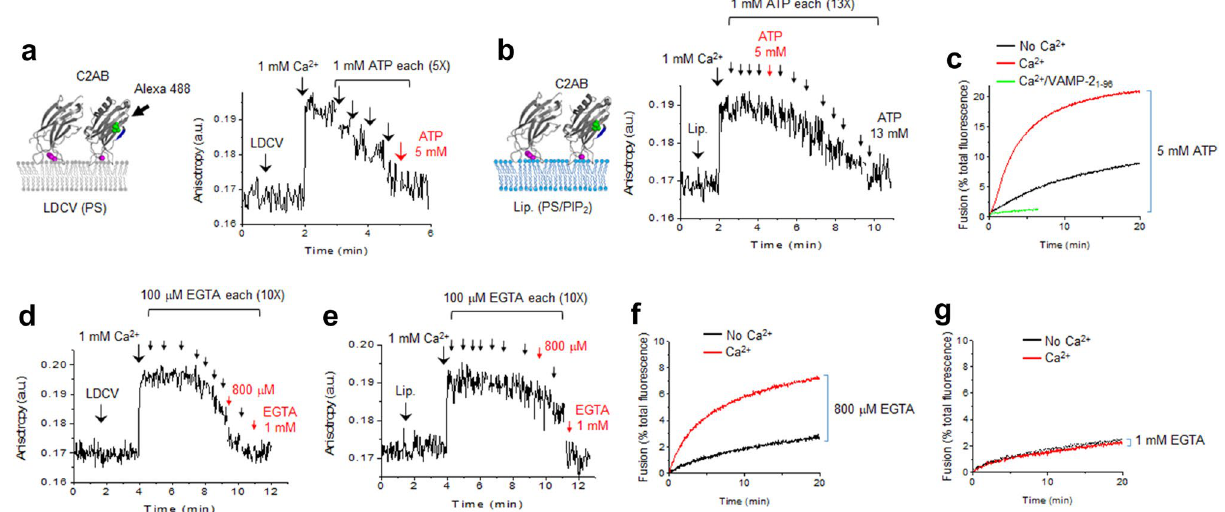
Figure 2. Monitoring cis- and trans -membrane interaction of synaptotagmin-1. ( a ) Binding of the C2AB domain of synaptotagmin-1 to the membrane of native vesicles (i.e., LDCVs) was monitored using fluorescence anisotropy in which the C2AB domain (Syt-1 97–421 ) was labelled with Alexa Fluor 488 at S342C (green dots). (Left) The C2AB domain has Ca 2+ -binding sites (magenta) and the Ca 2+ -bound C2AB domain is inserted to membrane, thus decreasing the rotational mobility. LDCVs contain anionic phospholipids, equivalent to around 15% PS 10 . (Right) A dose of 1 mM Ca 2+ was applied to induce binding of the C2AB domain to LDCVs, then 1 mM ATP was added five times (arrows) to reverse this binding. The final total of 5 mM ATP disrupted membrane binding of the C2AB domain (red). ( b ) C2AB domain binding to the PM-liposomes. 1 mM ATP was added thirteen times (arrows) and the final total of 13 mM ATP reversed membrane binding of the C2AB domain; the C2AB binding remained in 5 mM ATP (red). ( c ) In-vitro reconstitution of LDCV fusion using a lipid-mixing assay. Purified LDCVs were incubated with the PM-liposomes that incorporate the stabilized Q-SNARE complex. 1 mM Ca 2+ in the presence of 5 mM ATP accelerated LDCV fusion. ( d , e ) Binding of the C2AB domain to LDCVs ( d ) and the PM-liposomes ( e ) was monitored using fluorescence anisotropy as in a , b . First, 1 mM Ca 2+ was applied to induce binding of the C2AB domain, then 100 μM EGTA was added ten